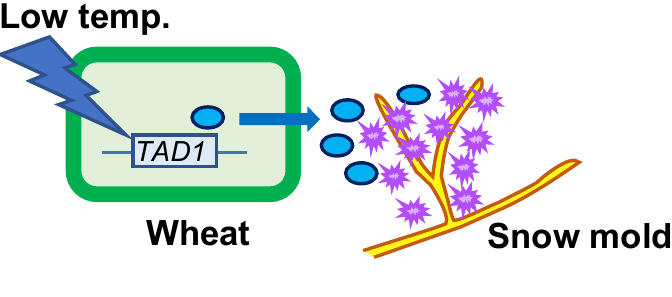
Figure 5. A proposed model for interaction of defense mechanisms between wheat and M. nivale .